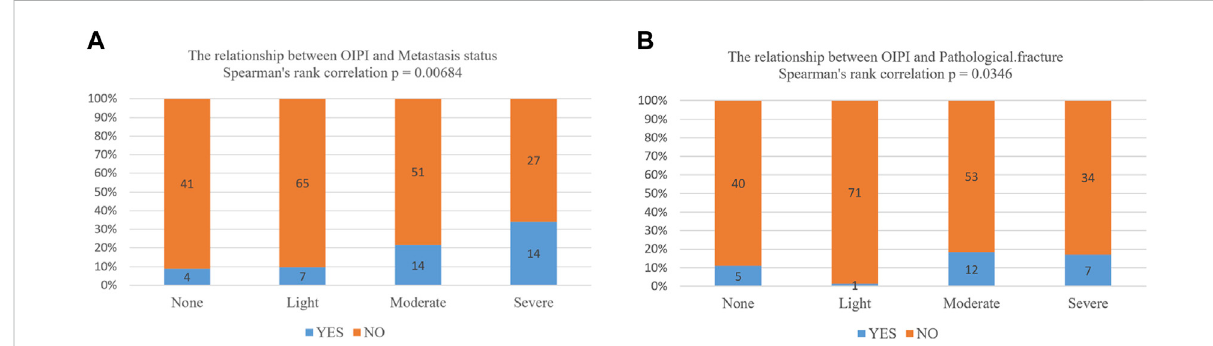
FIGURE 7 AssociationbetweenOIPIandclinicalcharactersincludingmetastasisandpathologicalfracture. (A,B) TheSpearman ’ srankanalysisshowedthat OIPI was related to the metastasis and pathological fracture. OIPI, osteosarcoma immune prognostic